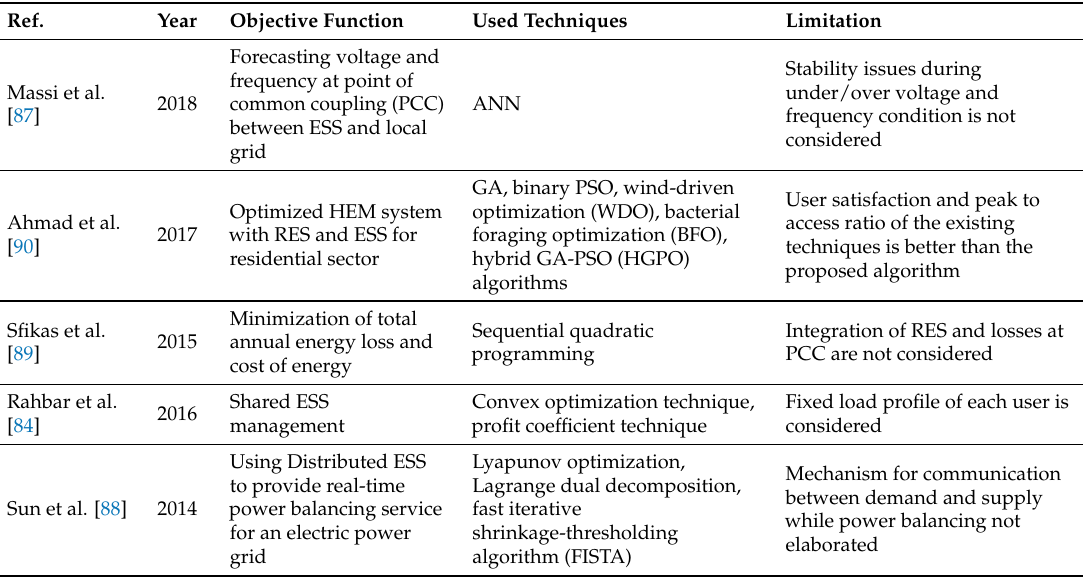
Table 3. AI techniques for the integration of